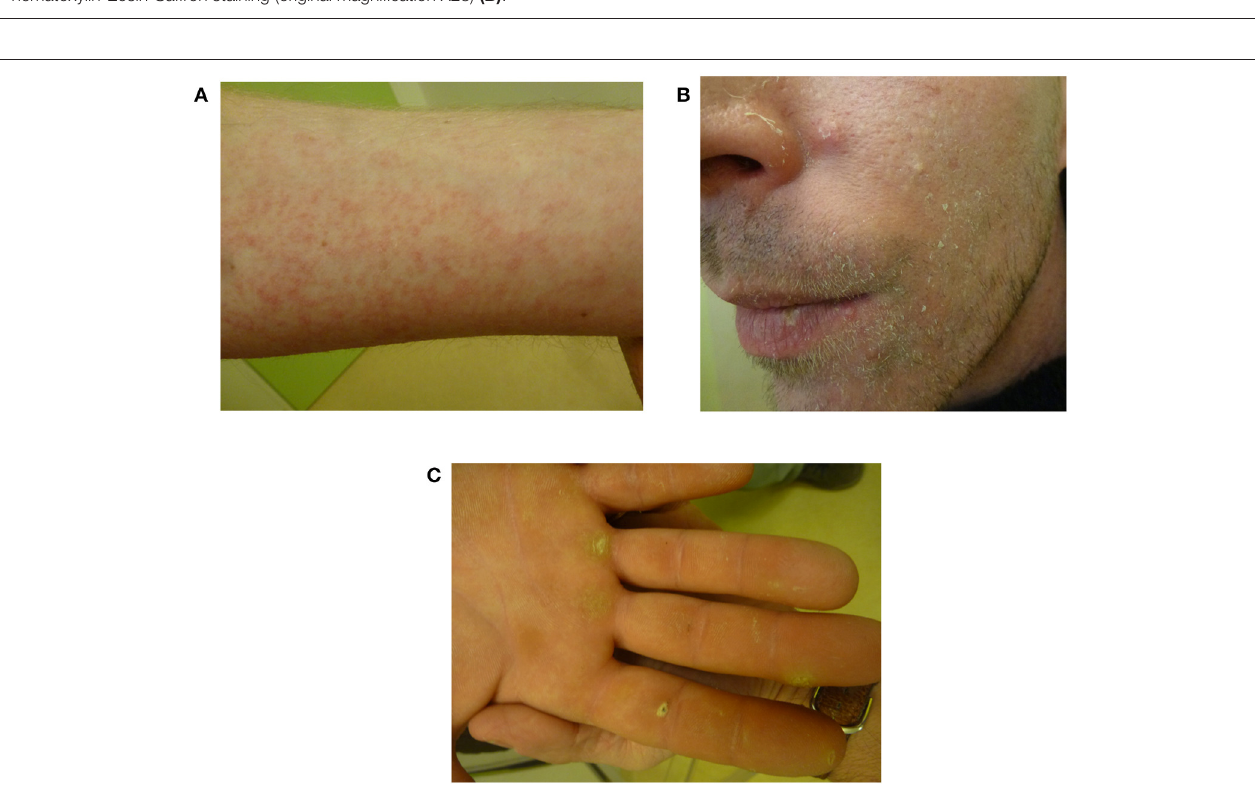
FIGURE 3 | Dermatological toxicities after 13 months of vemurafenib, representing a grade II maculopapular rash (A) , microcysts (B) , and hyperkeratosis as part of palmar-plantar erythrodysesthesia syndrome (C)